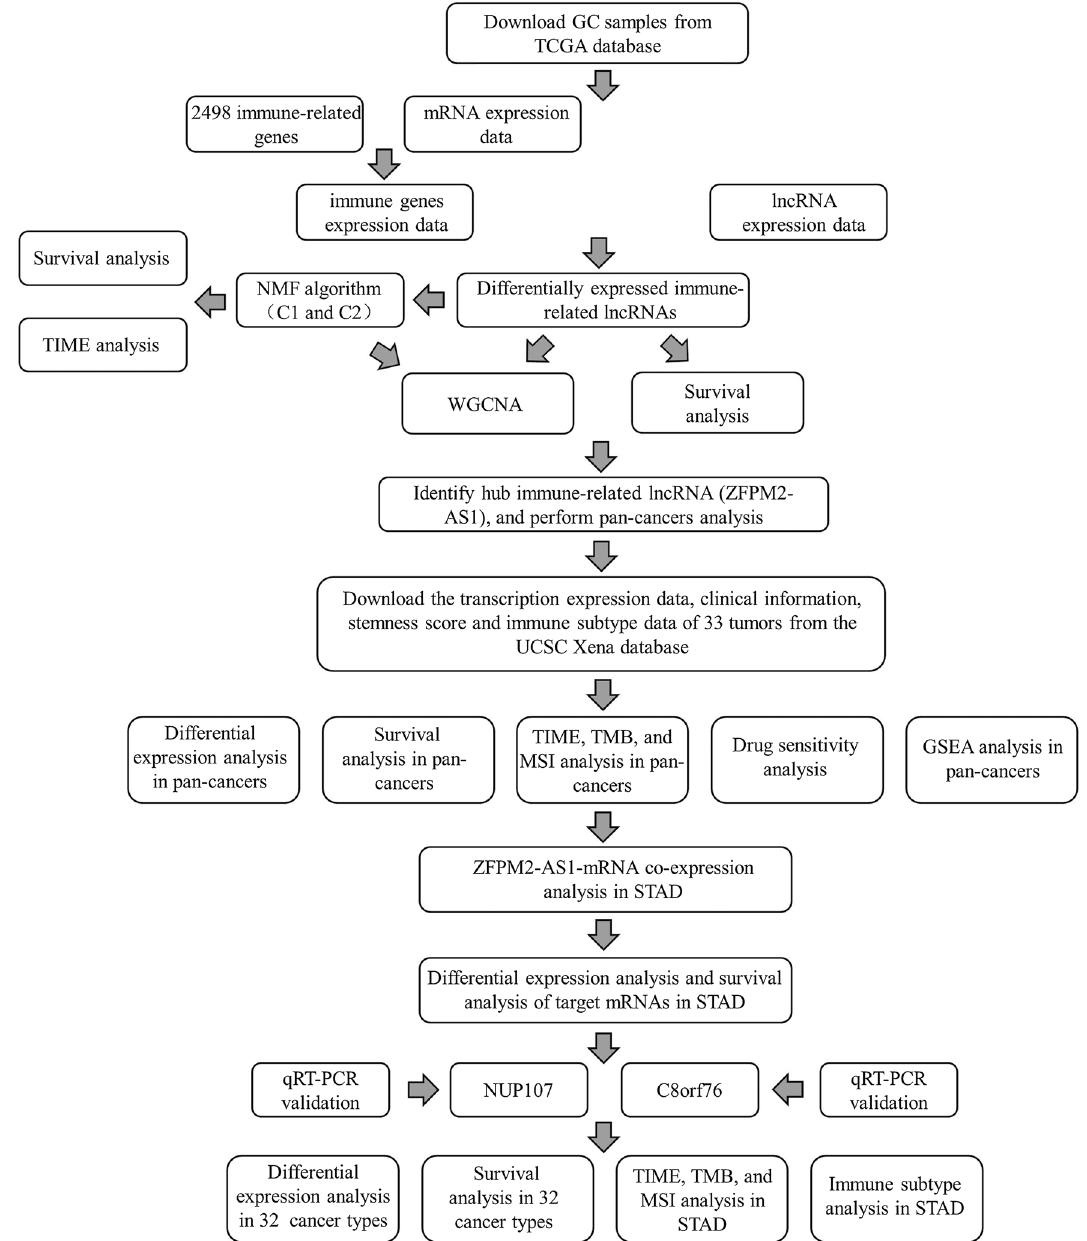
Fig. 1 Flowchart of the pan-cancer analysis of